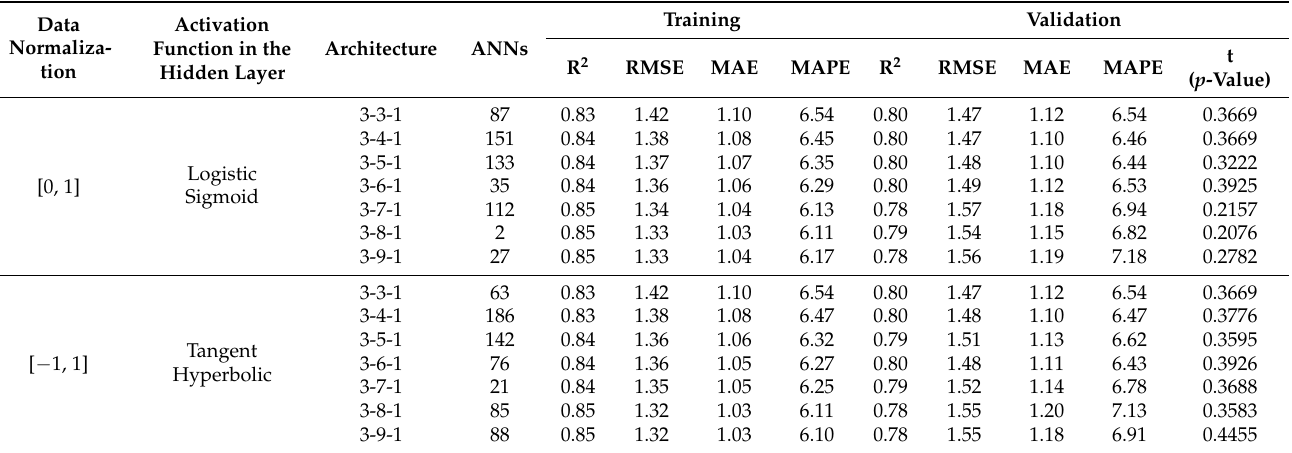
Table 3. Precision measures of the studied Artificial Neural Networks (ANN) variations for height estimation of Brazilian